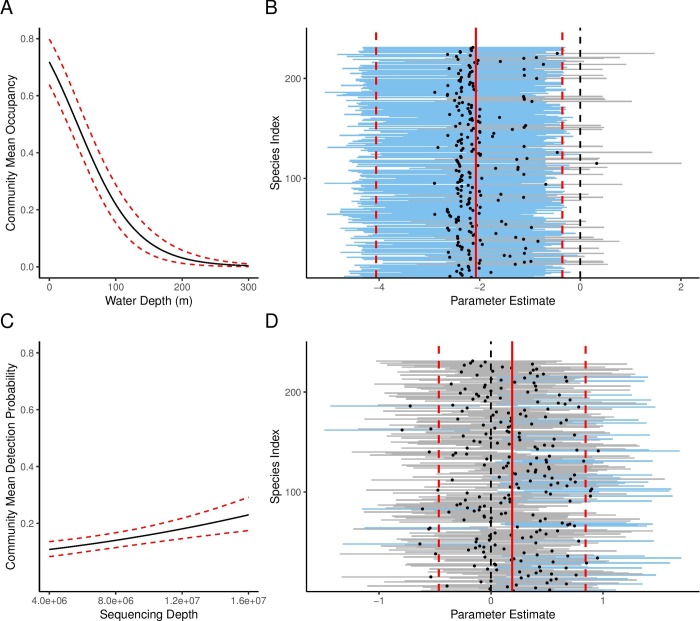
(A) Community mean occupancy by water depth (m) and (C) community mean probability of detection by sequencing depth predicted using a multi-species, multi-scale community occupancy model. The dashed lines represent the 95% confidence interval. Parameter estimate for each species for (B) the effect of water depth on occupancy and (D) the effect of sequencing depth on detection in a multi-species, multi-scale community occupancy model. Solid red line indicates the community mean and dashed red lines indicate the upper and lower limits of the 95% confidence intervals of the community mean parameter estimate. Blue lines indicate 95% confidence intervals of individual species parameter estimates that do not overlap with 0. Grey lines indicate 95% confidence intervals of individual species parameter estimates that do overlap with 0.